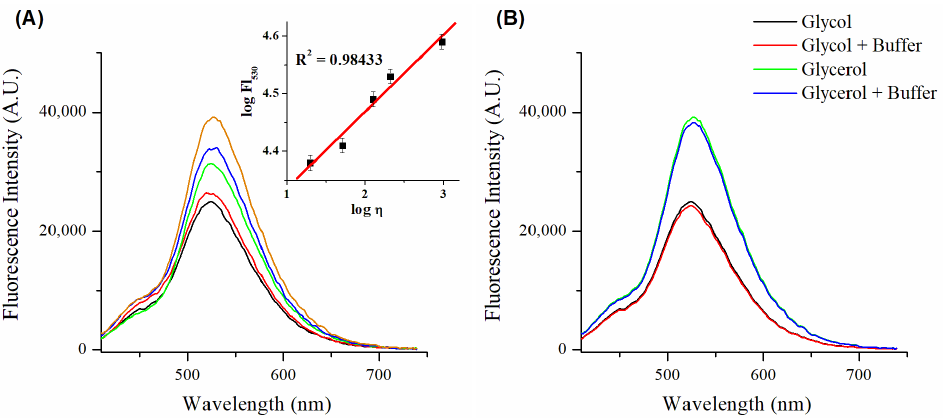
Figure 4. Normalized to the optical density fluorescent spectra ( λ ex = 400 nm) of probe 3 ( A ) in glycol (black line), glycol/glycerol = 3:2 v / v (red line), glycol/glycerol = 1:1 v / v (blue line), glycol/glycerol = 2:3 v / v (green line), and glycerol (orange line), and ( B ) in glycol, buffered glycol containing 10 µM Tris-HCl (pH 8), glycerol, and buffered glycerol containing Tris-HCl (pH 8).